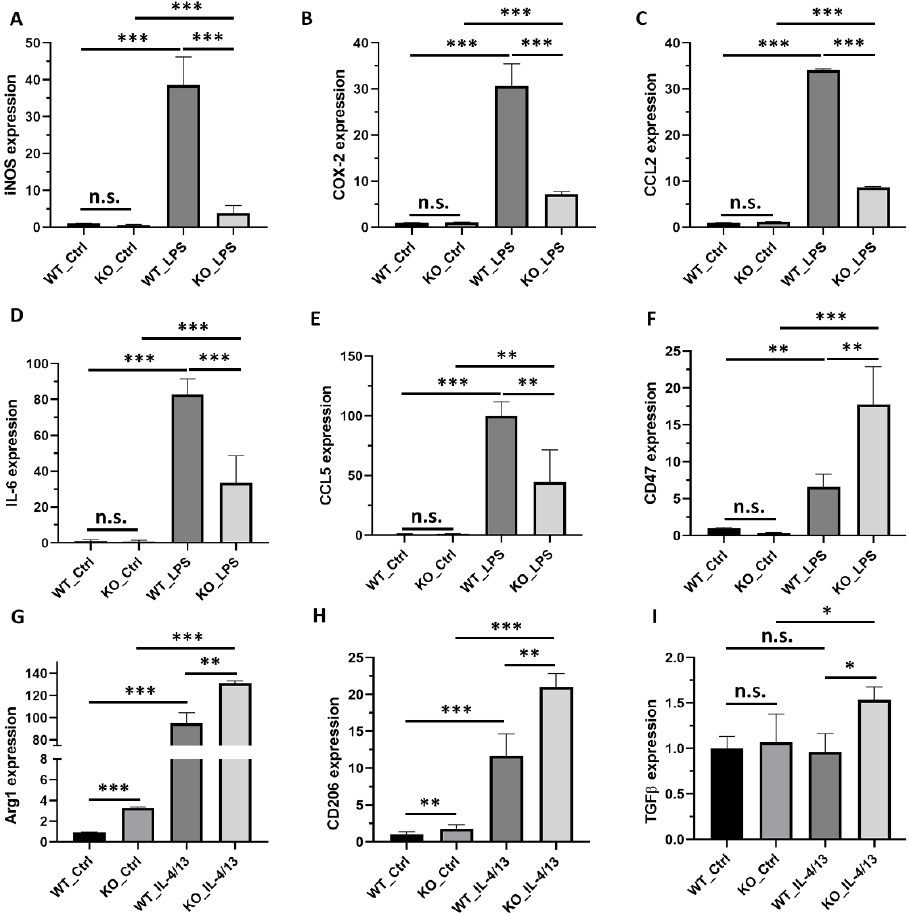
Figure 5. IRF1 KO alters gene expression of the M1/M2 microglial activation state. Eighty percent confluent IRF1-KO BV2 cells (BV2 ΔIRF1 ) and wild-type (WT) cell cultures were treated with LPS or IL4/13 (PBS as control) for 24 h. The qPCR results for mRNA expression of iNOS ( A ), COX-2 ( B ), CCL2 ( C ), IL-6 ( D ), CCL5 ( E ), CD47 ( F ), Arg1 ( G ), CD206 ( H ), and TGFβ ( I ). The replicate numbers = 6. n.s. p > 0.05; * p < 0.05; ** p < 0.01; *** p < 0.001.